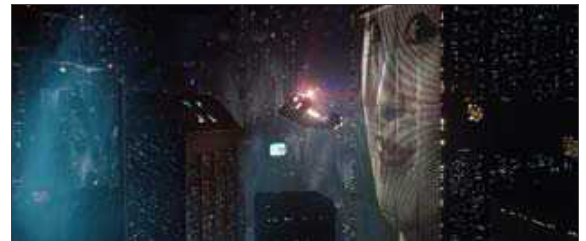
12 pav. toyo Ito Vėjų bokštas 1986 m. Fig. 12. toyo Ito “tower of winds”,